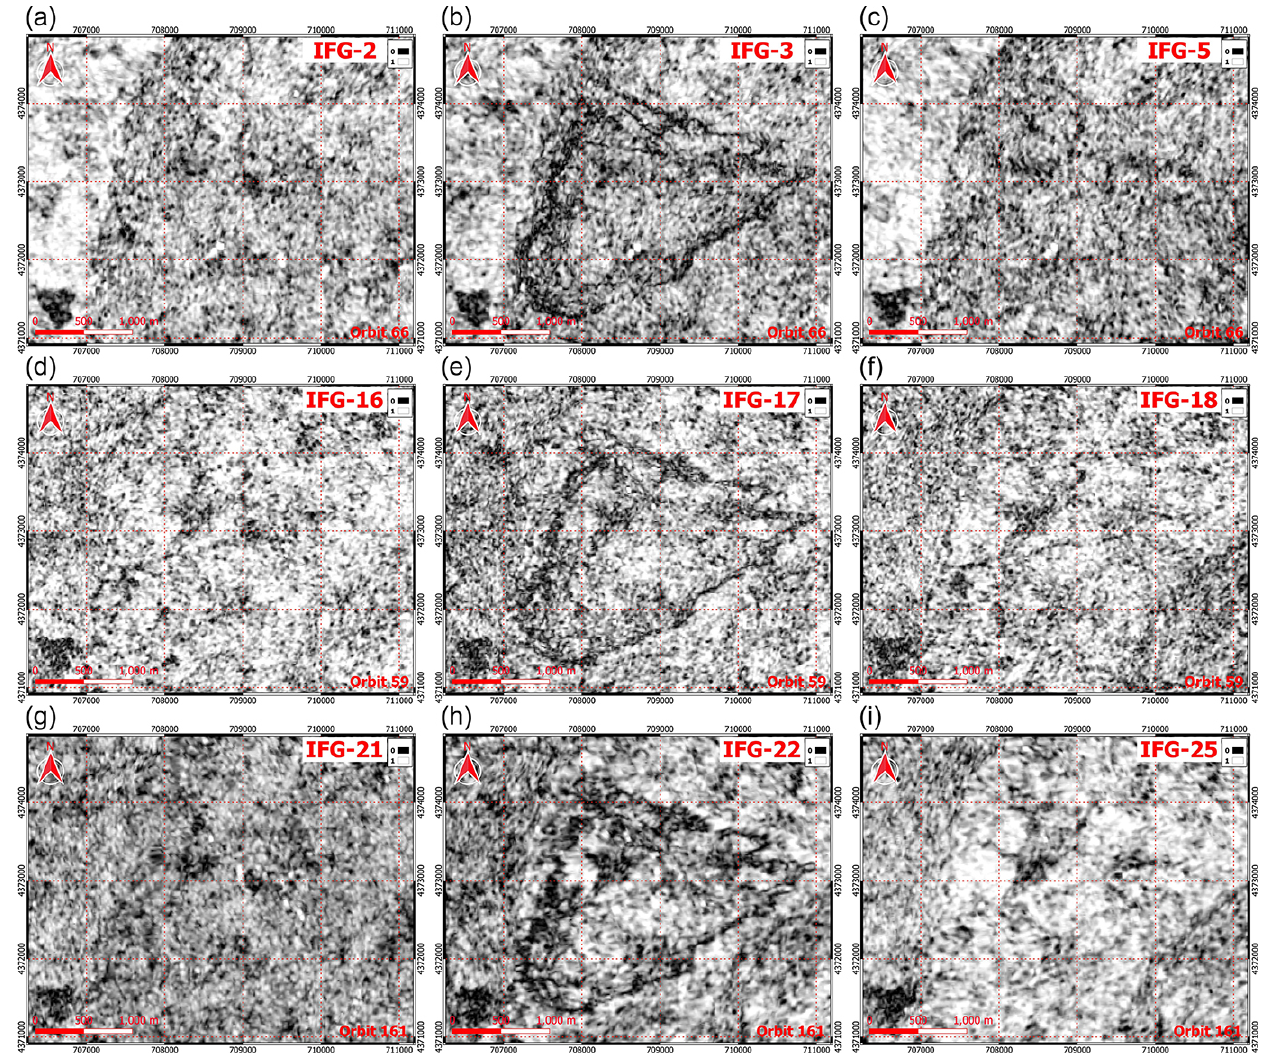
Figure 8. Coherence maps of Grarem AoI: the images represent pre-event (a, d, g) , co-event (b, e, h) , and post-event (c, f, i) for orbits 66, 59, and 161. Note: the co-event maps for the three orbits show the decay of coherence that is triggered by the